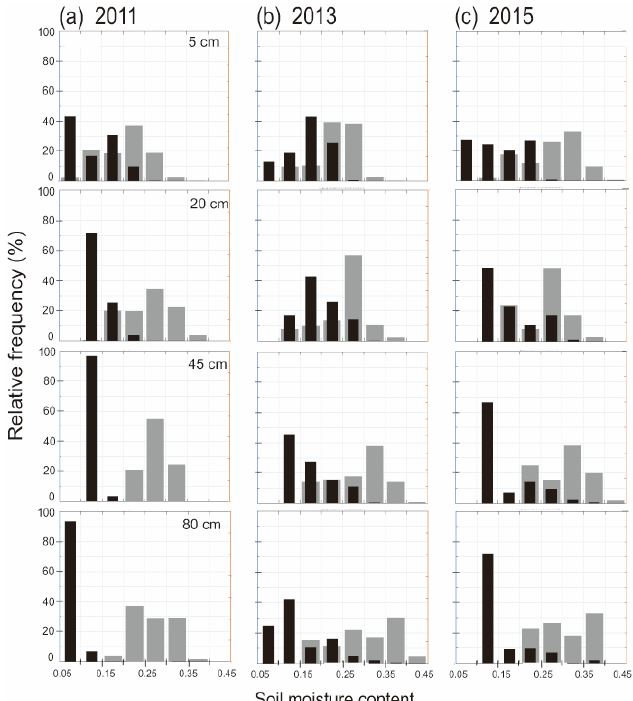
Figure 2. Relative frequency distribution of soil moisture content under grassland (grey bar) and woodland (black bar) at di ff erent soil depths in ( a ) a drought year, 2011, ( b ) a normal year, 2013, and ( c ) a pluvial year,